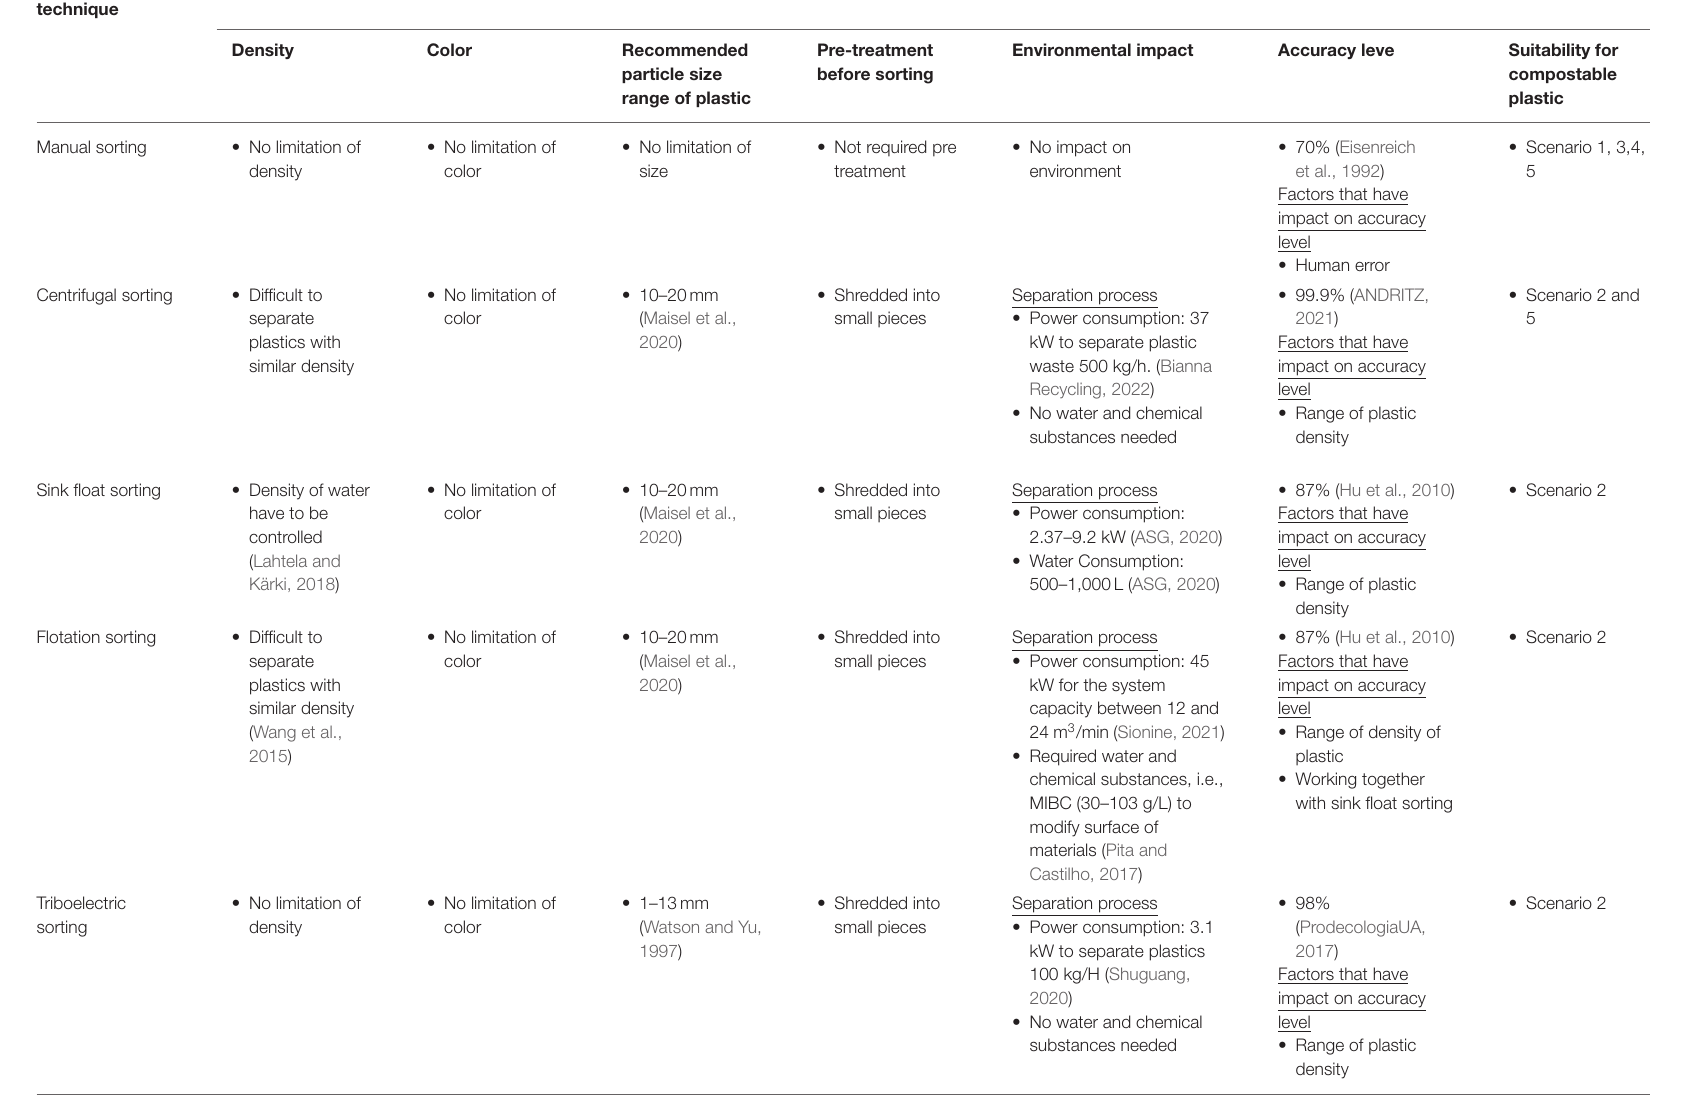
TABLE 2 | Advantages and drawbacks of various sorting